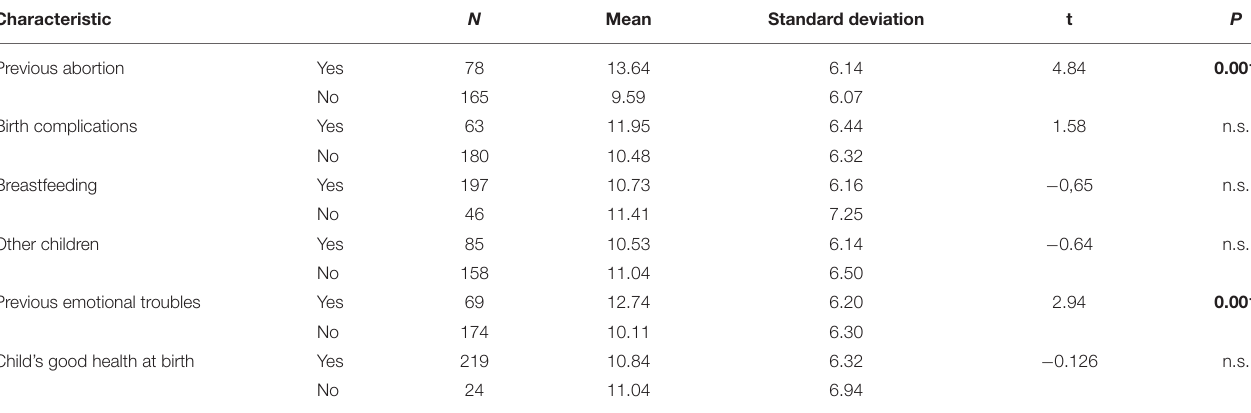
Bold values indicates the significant values.